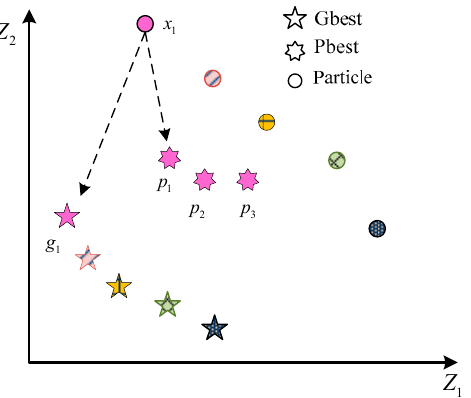
Figure 7. Illustration of the selection mechanism of local optimal guide.